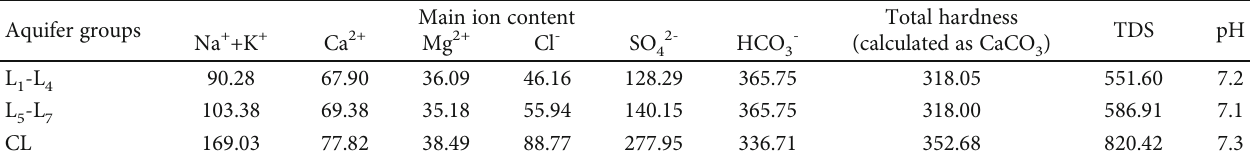
Table 3: Contents of main ionic components in groundwater in di ff erent aquifers of mine No. 13 (mg/L).